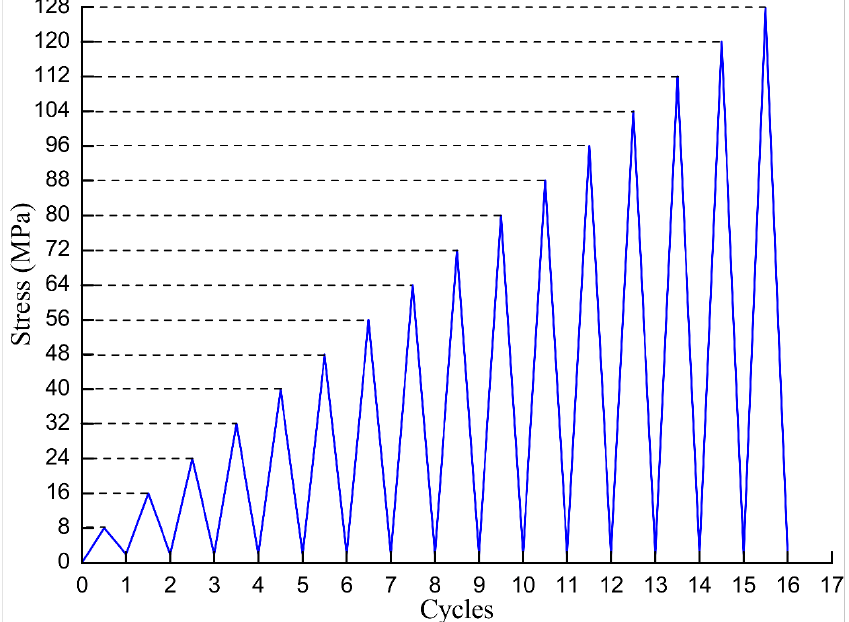
Figure 1. Evolution curve of rock stress with cycle number for cyclic loading and